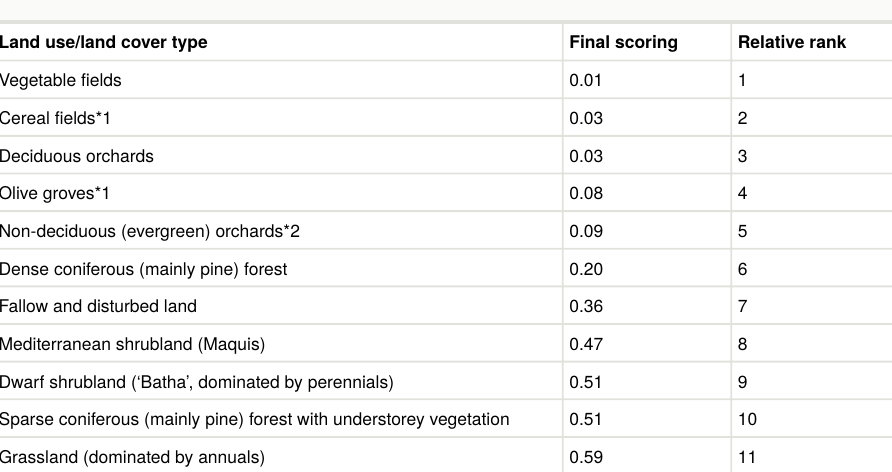
that were used for the creation of the